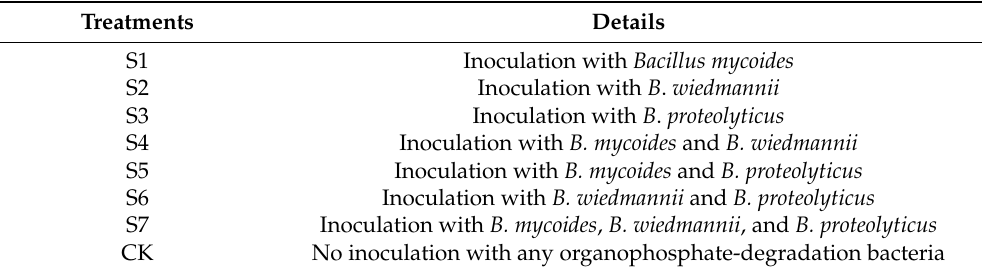
Table 4. The arrangement of each treatment in this experiment. Treatments Details S1 Inoculation with Bacillus mycoides S2 Inoculation with B . wiedmannii S3 Inoculation with B . proteolyticus S4 Inoculation with B. mycoides and B. wiedmannii S5 Inoculation with B. mycoides and B. proteolyticus S6 Inoculation with B. wiedmannii and B. proteolyticus S7 Inoculation with B. mycoides , B. wiedmannii , and B. proteolyticus CK No inoculation with any organophosphate-degradation